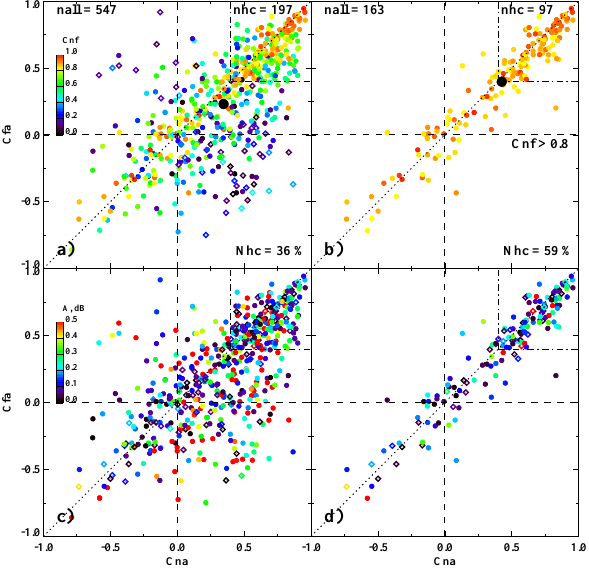
Fig. 6. The scatter plot of correlation coefficients ( C fa versus C na ) for (a) and (c) all correlation coefficients between STARE Norway and Finland backscatter powers C nf and (b) and (d) for C nf > 0.8. All points in panels (a),(b) and (c),(d) are colour-coded in C nf and absorption intensity A , with the colour bar shown in the top-left corner of panels (a) and (c), respectively. The points correspond- ing to the positive (negative) C nf and A are marked with circles (diamonds). The total number of all points n all (points with suf- ficiently high correlations n hc ) is shown in the top-left (top-right) corner with percentage of the HCPs N hc = n hc /n all shown in the bottom-right corner of panels (a) and (b). The large black circles in panels (a) and (b) mark the mean ( C na , C fa